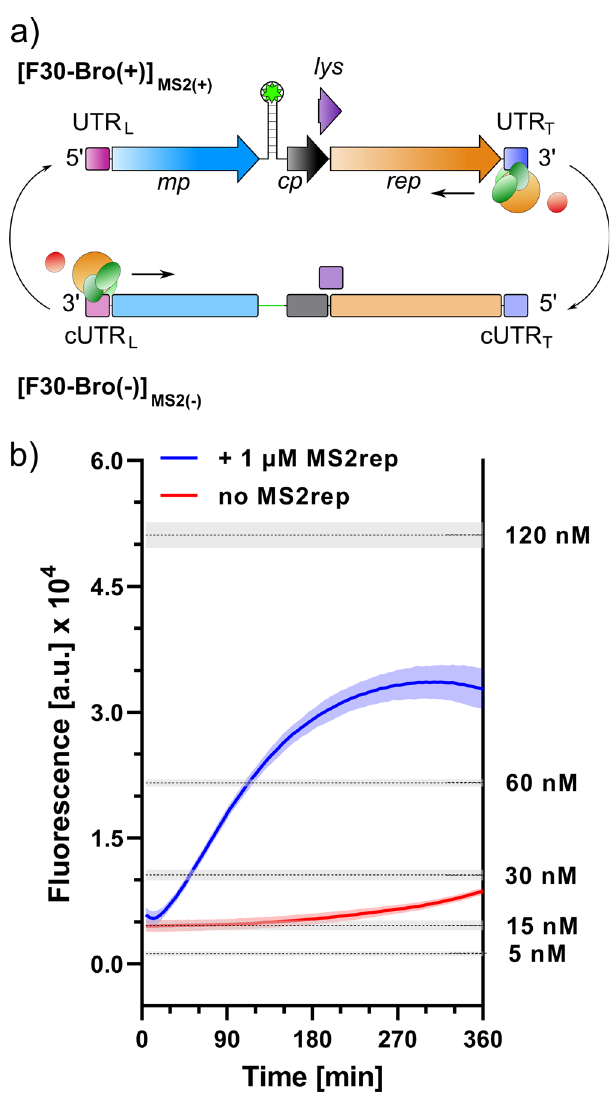
Fig. 4 Full-length MS2 genome replication in PURExpress. a Replication scheme of [F30-Bro( + / − )] MS2( + / − ) RNA by the MS2rep complex. b Fluorescence change over the 6-h incubation at 37 °C for replication analysis of 15 nM [F30-Bro( + )] MS2( + ) in PURExpress with (blue) and without (red) 1 µ M MS2rep. Grey lines indicate average fl uorescence levels of reference concentrations of in vitro transcribed [F30-Bro( + )] MS2( + ) in PURExpress. Standard deviations are derived from three independent